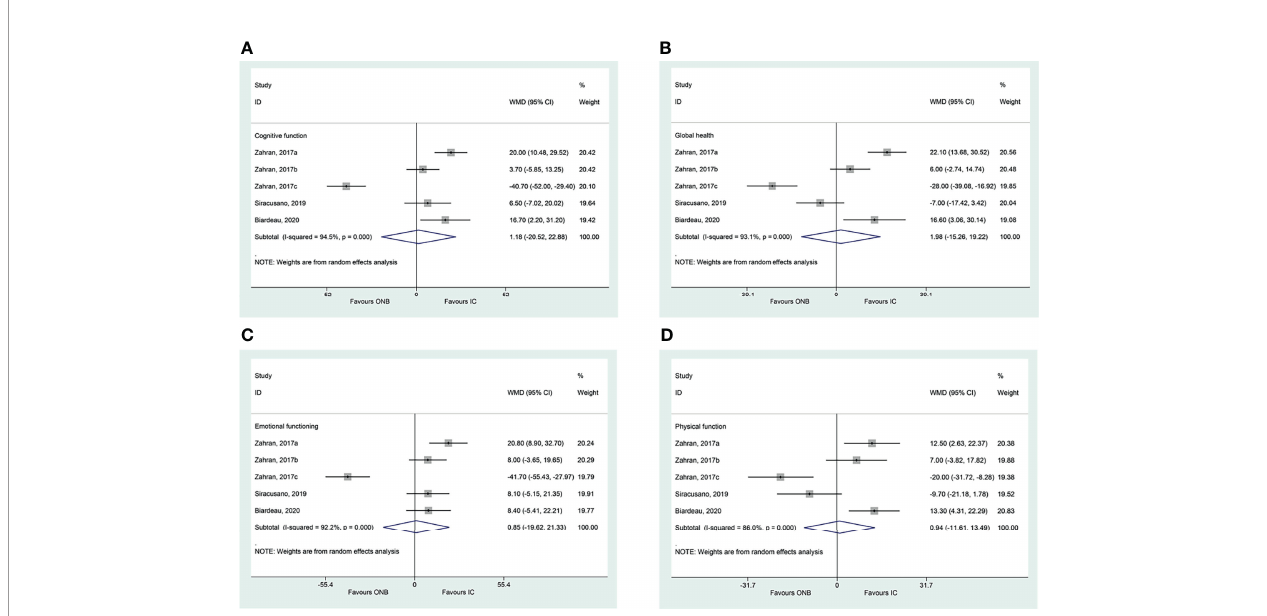
FIGURE 2 | (A) Forest plot of cognitive functioning in women with bladder cancer who underwent ileal conduit diversion (IC) or orthotopic neobladder (ONB) (B) Forest plot of global health in women with bladder cancer who underwent ileal conduit diversion (IC) or orthotopic neobladder (ONB). (C) Forest plot of emotional